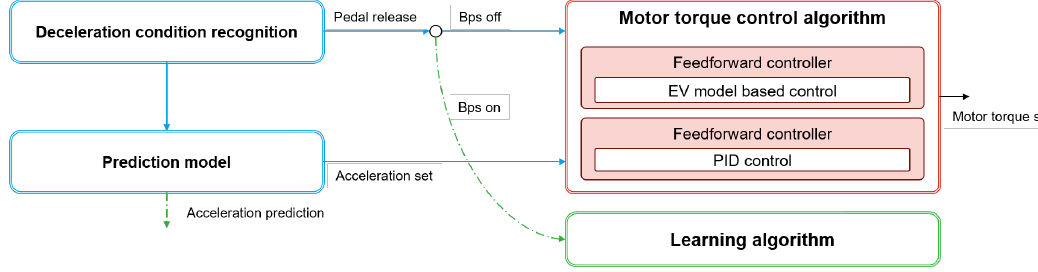
Figure 25. Structure of the regenerative controller based on the proposed driver